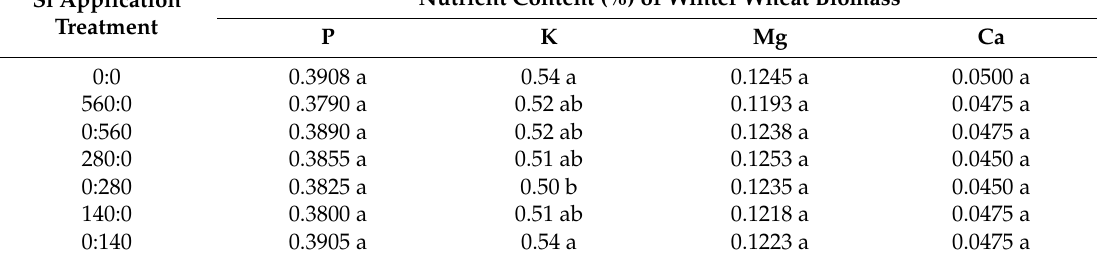
Table 1. Effect of different Si rates and application time on winter wheat biomass P, Mg, K, and Ca content at harvest in